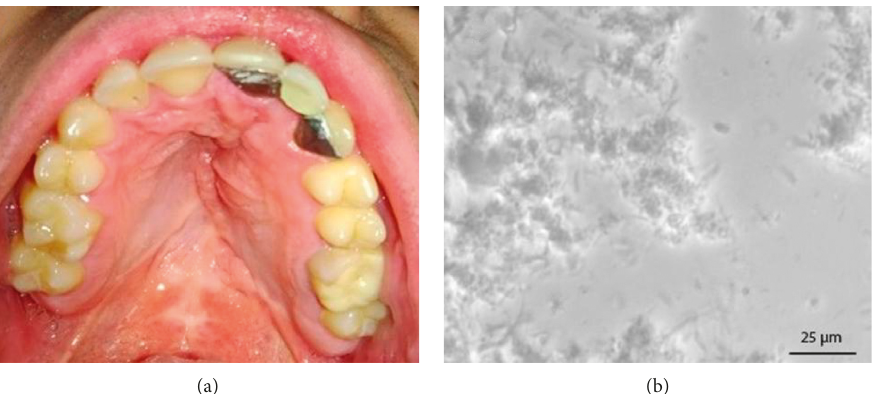
Figure 4: (a) Clinical improvement at the 2 years follow-up. (b) Normalization of oral flora after treatment ( × 1000 in patient’s